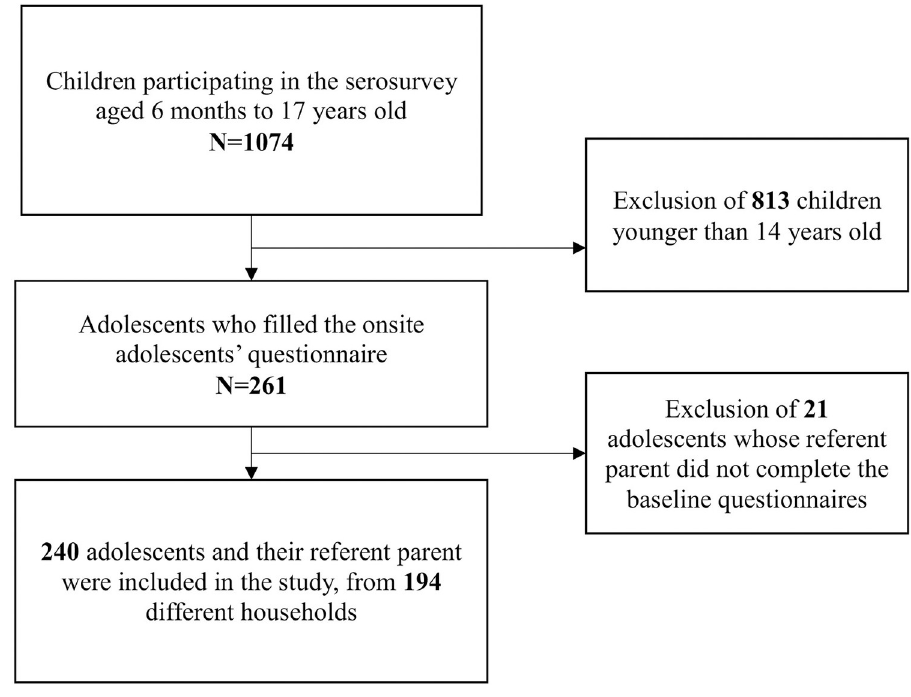
Fig 1. Study flow